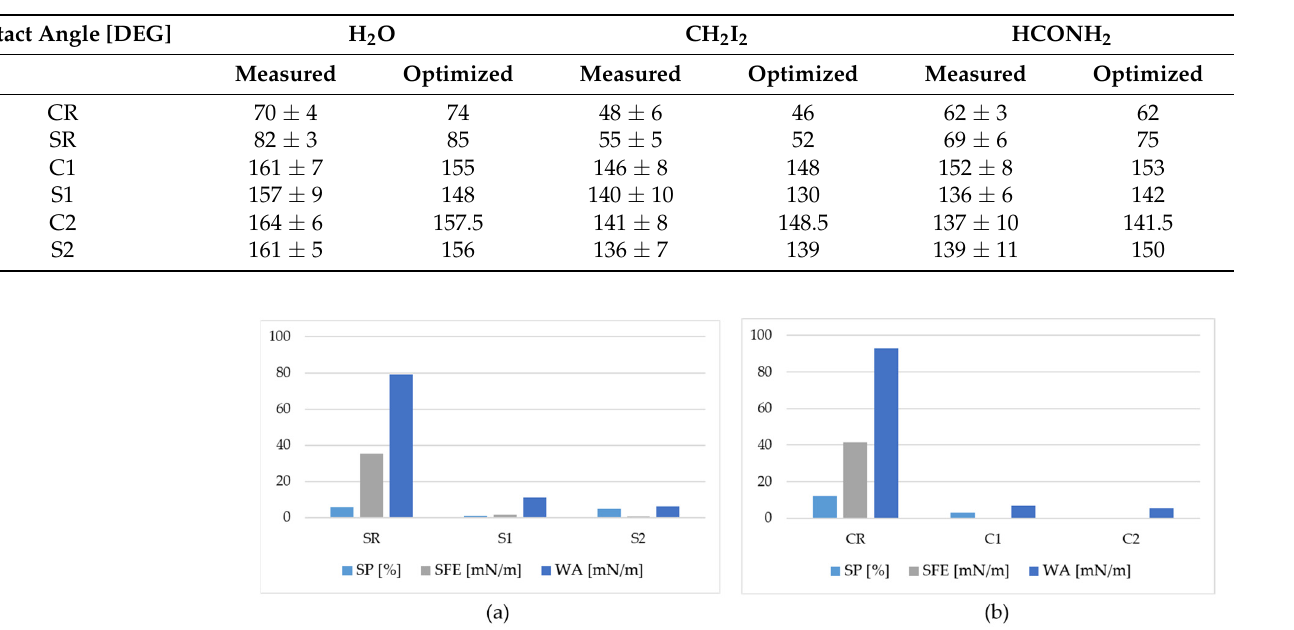
Figure 8. SFE, WA, and SP of SR, S1, and S2 ( a ), and of CR, C1, and C2 ( b ) samples.